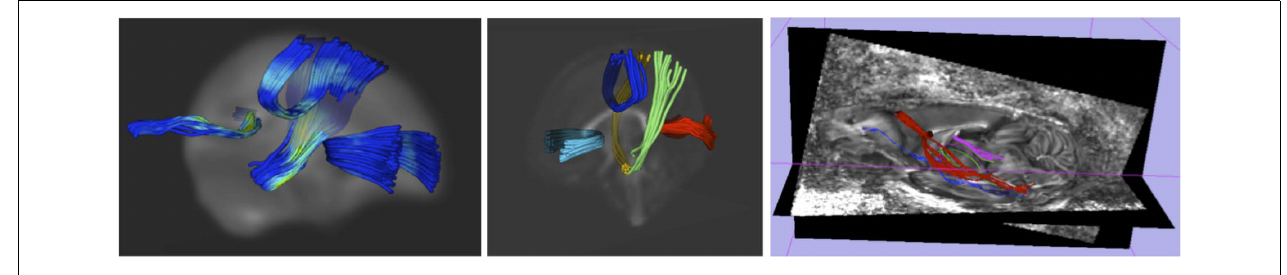
fractional anisotropy (left) and as multi-colored fiber tracts (middle). Right: genu fiber tract (red) in a rodent DTI scan (anterior commissure = blue, hippocampal commissure = pink).